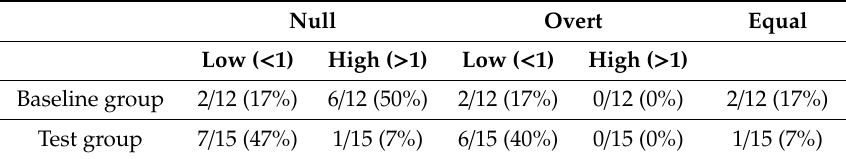
Table 4. Participants who favored null or overt C2 by a low / high